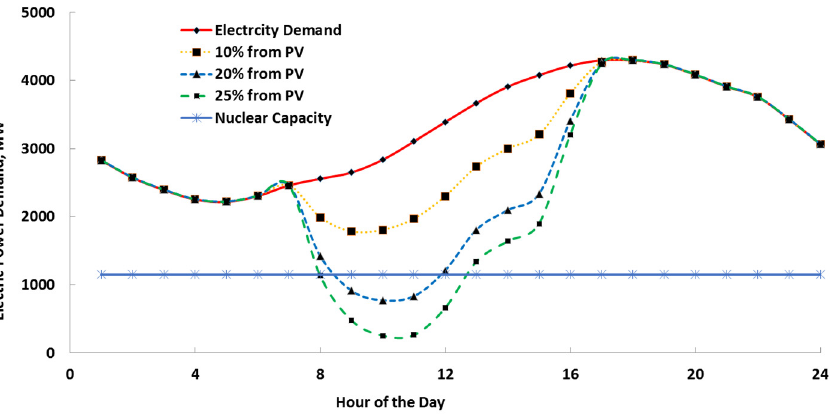
Figure 2. The duck curve generated when the PV-generated electricity reached 10%, 20% and 25% of the annually generated electricity in the San Antonio, Texas region.